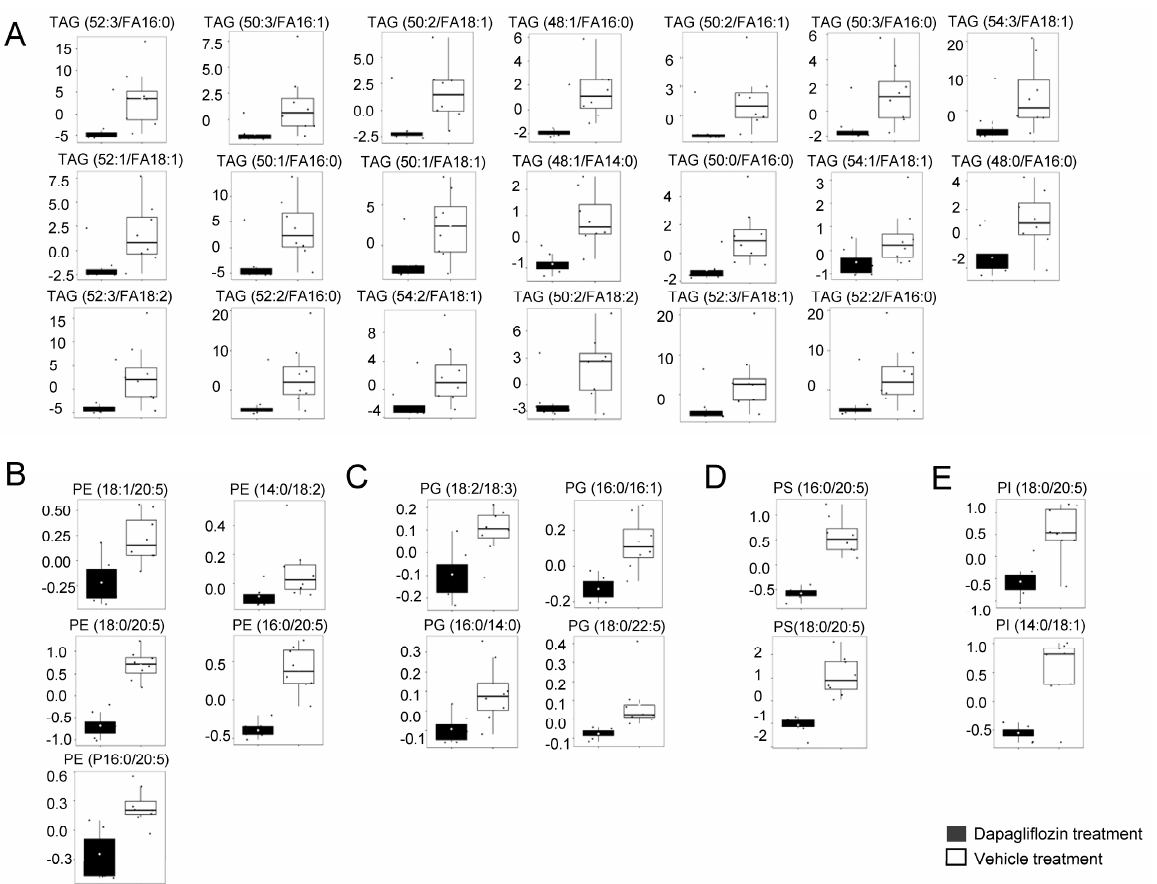
Figure 2. Lipids significantly downregulated in the kidneys of the dapagliflozin-treated salt-loaded hypertensive diabetic db/db mice compared to the vehicle-treated db/db mice. ( A ) Plots of triacyl- glycerols (TAGs), ( B ) plots of phosphatidylethanolamines (PEs), ( C ) plots of phosphatidylglycerols (PGs), ( D ) plots of phosphatidylserines (PSs), and ( E ) plots of phosphatidylinositols (PIs) significantly different between the two groups. The concentration of each lipid is given in µmol/g. The concentration of each lipid was normalized to the median. The black (left bar) represents the dapagliflozin group, and the white (right bar) represents the vehicle group.